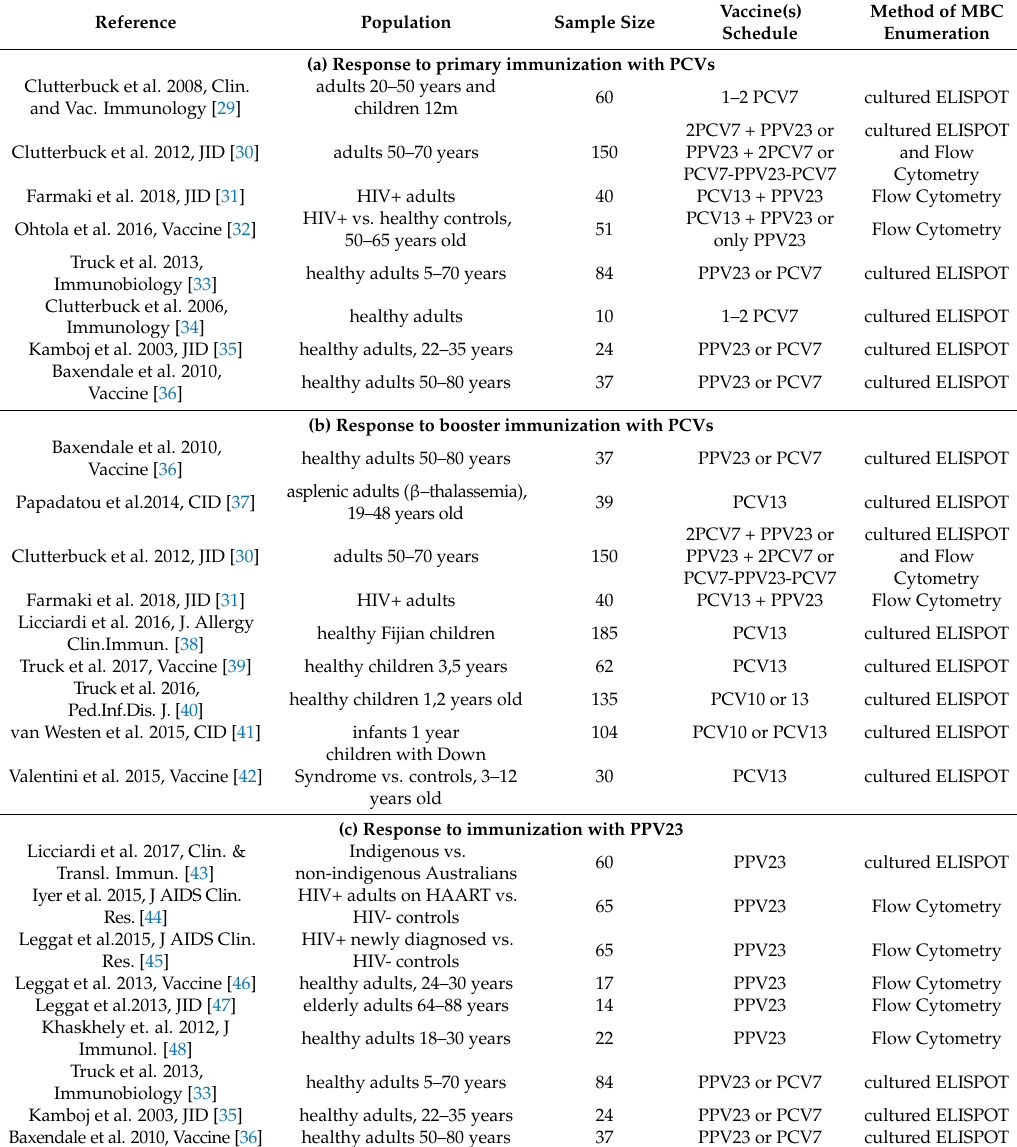
Table 2. Characteristics of studies describing memory B cells following primary and booster vaccination with pneumococcal